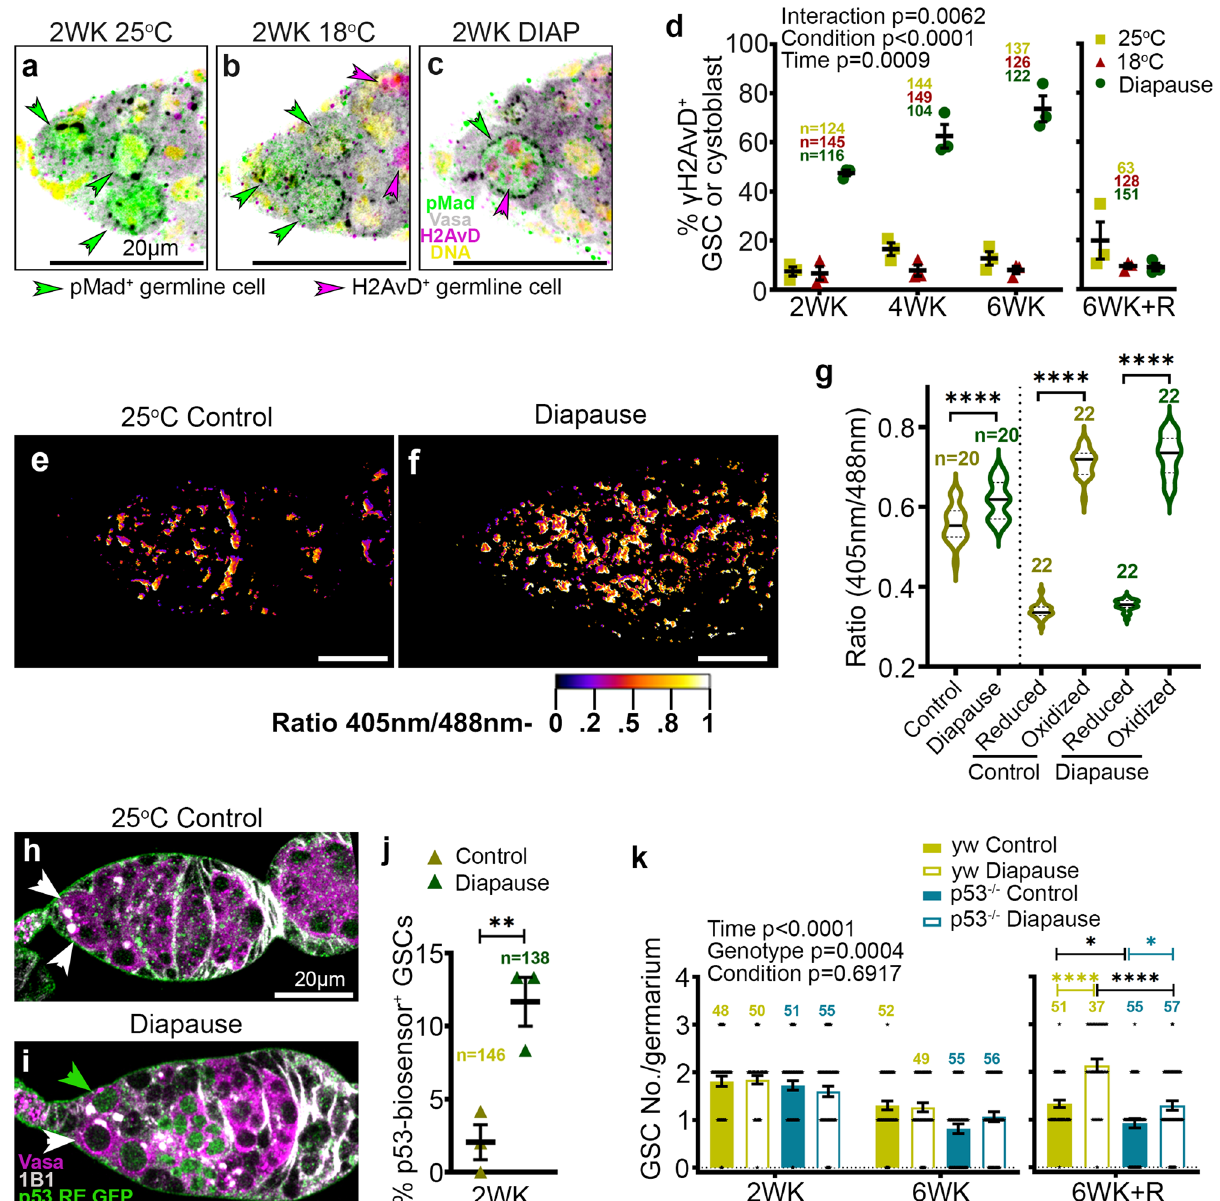
Fig. 4 DNA damage, ROS, and p53 mediated protective response in diapause. a – c Confocal micrographs of germaria from fl ies maintained for 2 weeks (WK) at 25 °C ( a ), 18°C ( b ), or diapause conditions ( c ). Anti-pMad (green) labels cells with active Dpp signaling from the niche. Anti- γ H2AvD (magenta) labels cells with double-strand DNA breaks due to damage [magenta arrowheads in ( c )] or meiosis (arrowheads in ( b )). d Percentage of H2AvD + cells out of total pMad + cells from 25 °C, 18 °C, and diapause over time. R, recovery. Statistical analysis is by 2-way ANOVA before recovery and 1-way ANOVA with Tukey ’ s multiple comparisons test after recovery. e , f Ratiometric (405 nm/488 nm) confocal micrographs of germaria from tubulin-mito-roGFP2- Orp1 fl ies kept for 2 weeks at 25 °C [control ( e )] and in diapause ( f ). g Quanti fi cation of ROS in the germarium relative to maximally reduced (with dithiothreitol) or oxidized (with diamide, see methods for details). Statistical analysis is by 1-way ANOVA and Tukey ’ s multiple comparisons test. **** p < 0.0001. h , i Confocal micrographs of germaria from fl ies maintained for 2 weeks (WK) at 25 °C ( h ), or diapause conditions ( i ). Anti-Vasa labels germline cells (magenta) and 1B1 stains the Hts protein indicating spectrosome/fusome (GSCs are shown by arrowheads). p53 RE GFP-NLS biosensor (green) labels cells with p53 activity (green arrowhead in ( i )). j Percentage of p53 RE GFP + GSCs out of total GSCs from 25 °C control and diapause for 2WK. p value from unpaired two-tailed t -test. ** p = 0.0095. k Quanti fi cation of GSC number/germarium from y, w control fl ies and p53 − / − in 25 °C control and diapause from 2WK, 6WK, and 6WK recovery (6WK + R). Statistical analysis is by three-way ANOVA before the recovery and one-way ANOVA after recovery. n is the number of GSCs analyzed in ( j ), in all other cases, n = number of germaria analyzed. Data are mean ± s.e.m. * p = 0.0211; * p = 0.0346; **** p < 0.0001. Scale bars are 20 µ m.